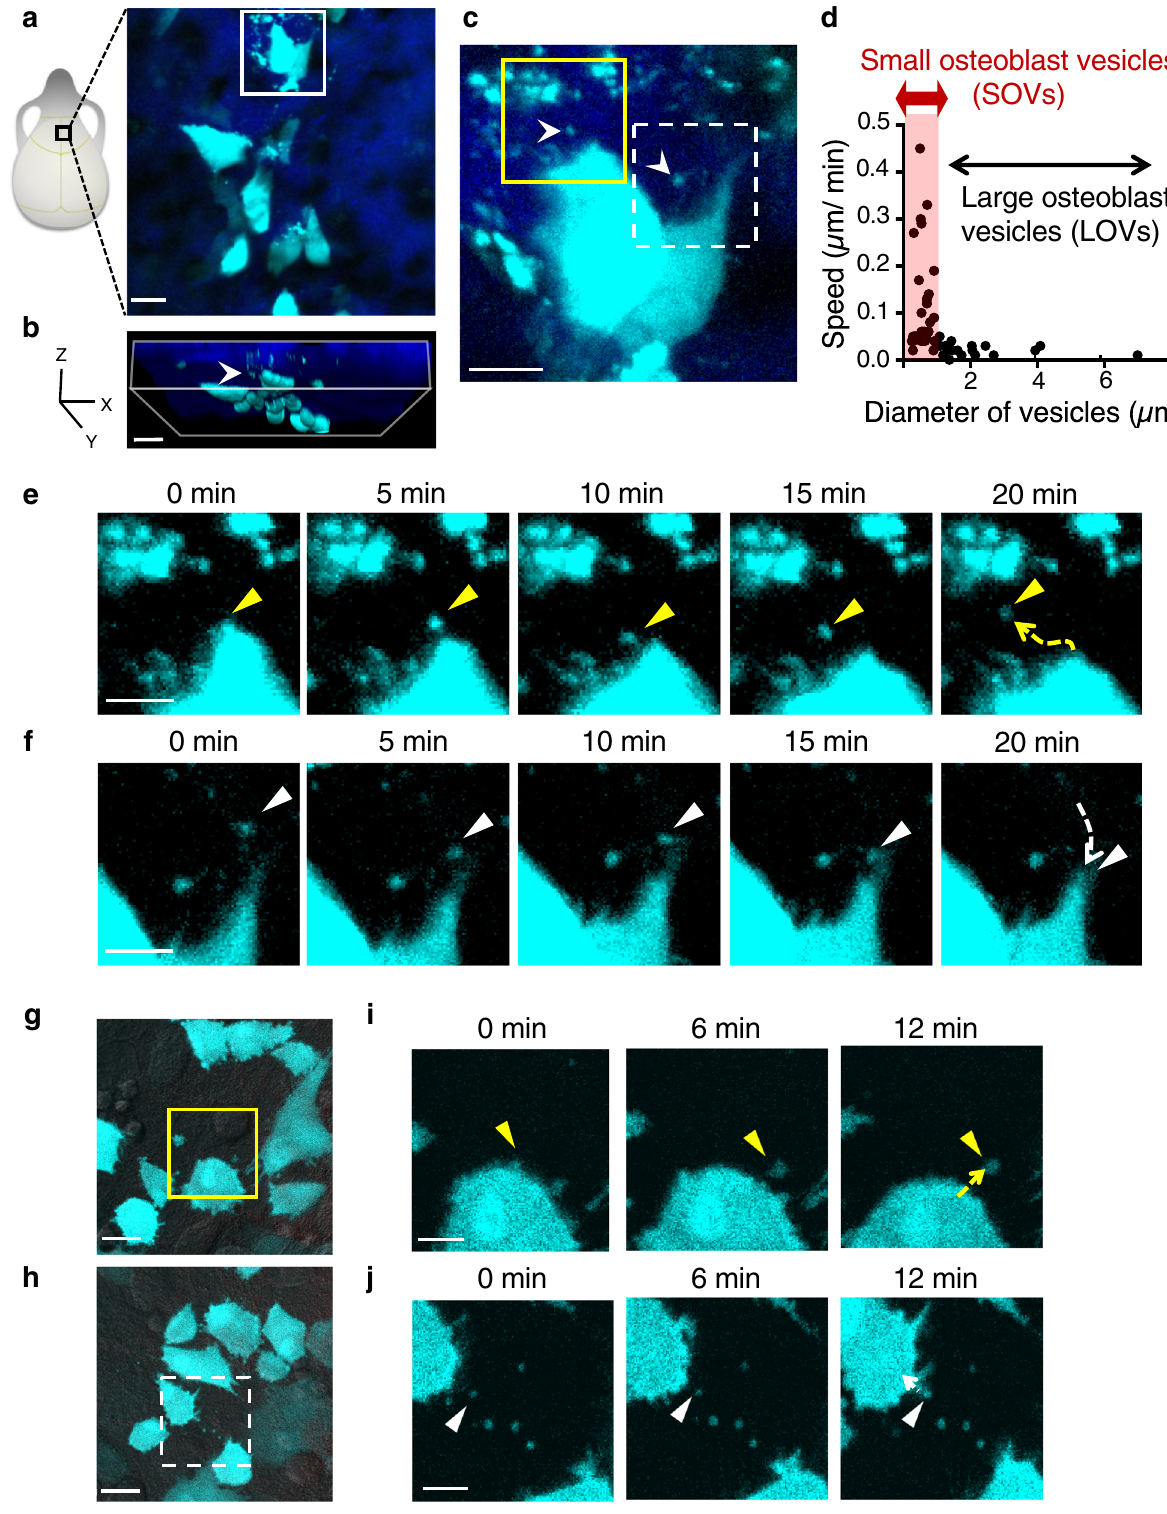
roles of SOVs in the expression of Rankl and Opg . The expression level of Rankl was signi fi cantly higher in the total SOV-treated group than in the PBS control group. In addition, the expression level of Opg was signi fi cantly lower in the total SOV-treated group than in the PBS control group. However, SOV-F1 did not affect Rankl or Opg expression (Fig. 3a). These results suggested an increased osteoclas- togenic potential in total SOV-treated mOBs. Therefore, we assessed